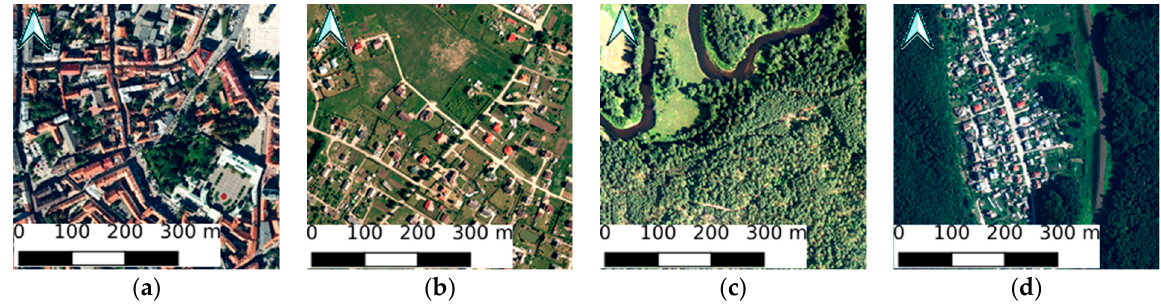
Figure 5. Sample images selected with a house centered ( a , b ) and random ( c , d ) which represent a diverse land use types, such as city ( a ), outskirts ( b ), vegetation ( c ), and village ( d ). The fine ‐ tuning dataset was created according to the same principles; however, the images were manually reviewed by removing the ones for which the labeled data did not meet the actual visible data. Such preparation of a dataset is a time ‐ consuming process